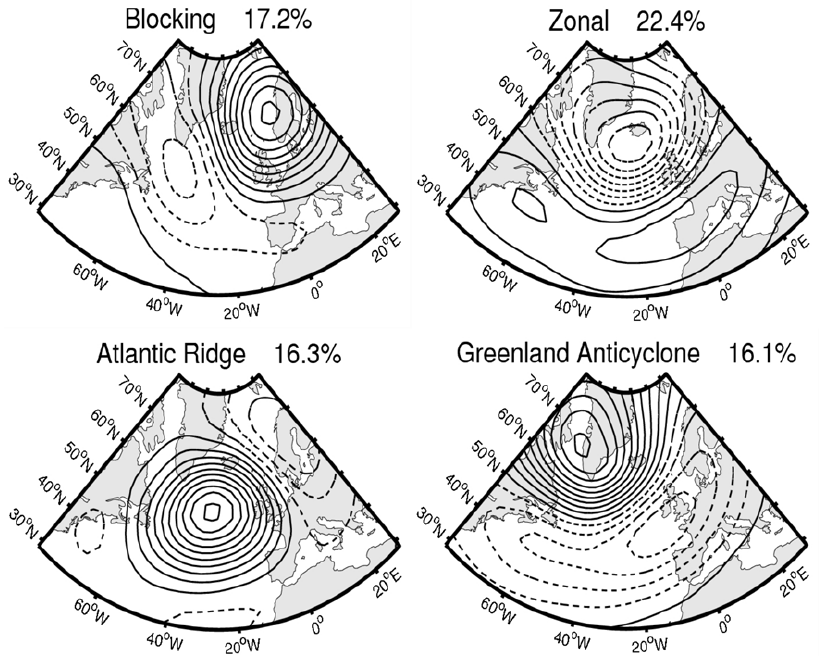
Fig. 1. The four atmospheric weather regimes (LAR). First row, Blocking (BL, left) and Zonal (ZO, right). Second row, Atlantic Ridge (AR, left) and Greenland Anticyclone (GA,